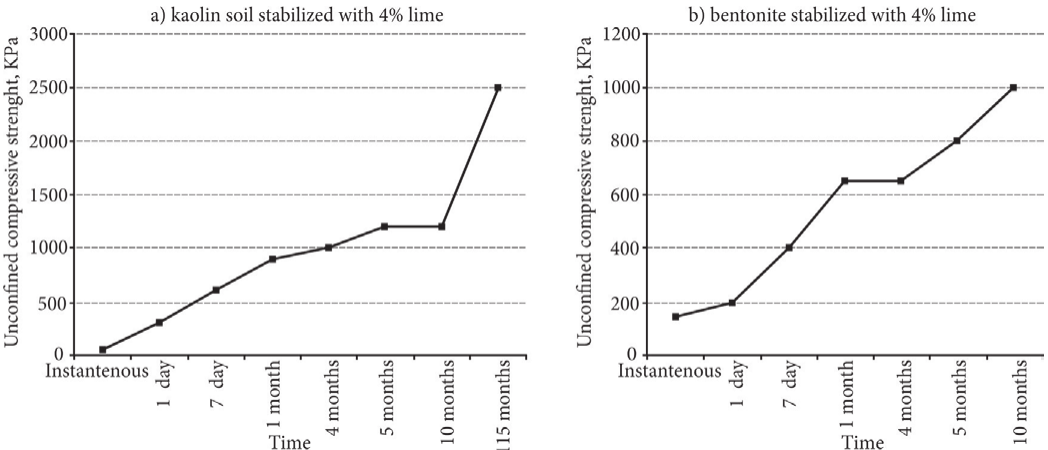
Figure 1. Unconfined compression value change of clayey soils with lime